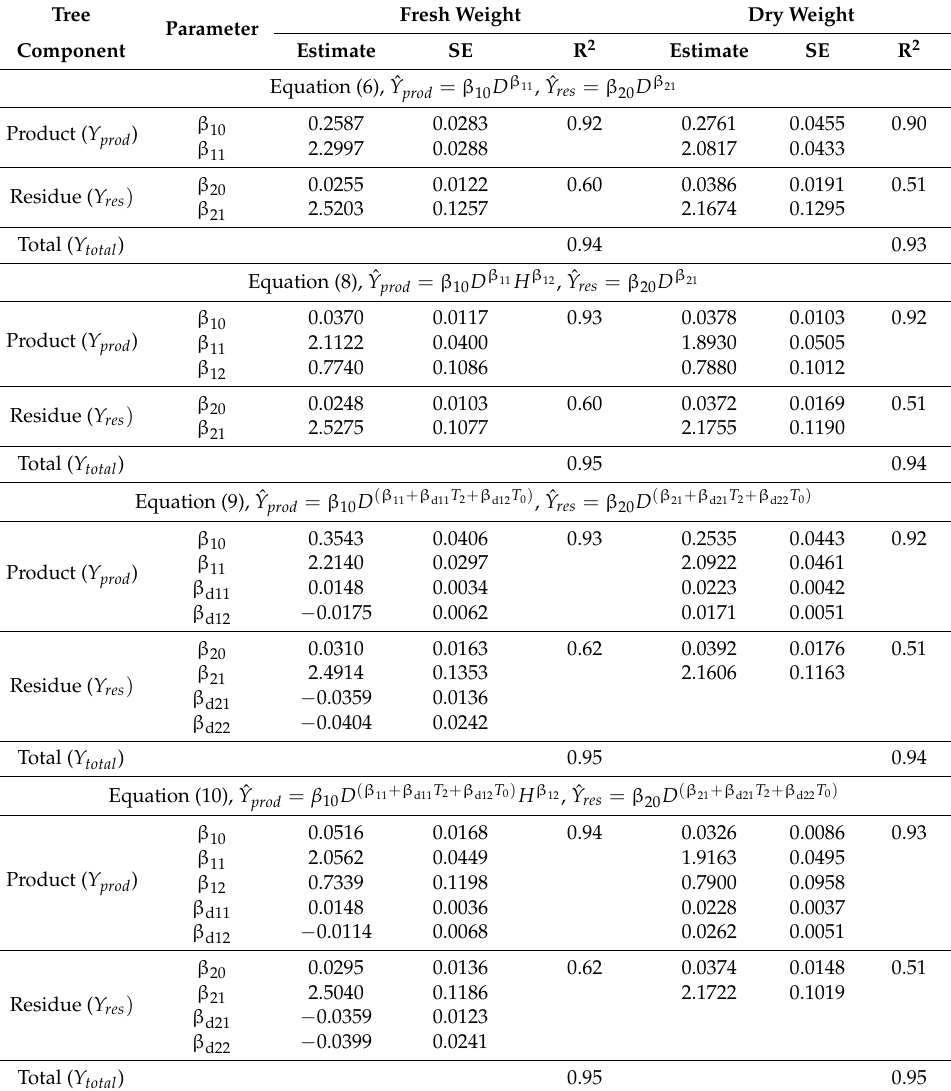
Table 4. Estimated parameters, their standard errors (SE) and R 2 for the four systems of additive equations for fresh and dry weight prediction. The one-variable model used DBHOB as the only predictor and the two-variable model involved both DBHOB and total tree height. ˆ Y prod and ˆ Y res represent the predicted values of Y prod and Y res . For all systems of equations in the table, ˆ Y total = ˆ Y prod + ˆ Y res , i.e., the predicted value of total tree biomass is equal to the sum of the predicted values of its